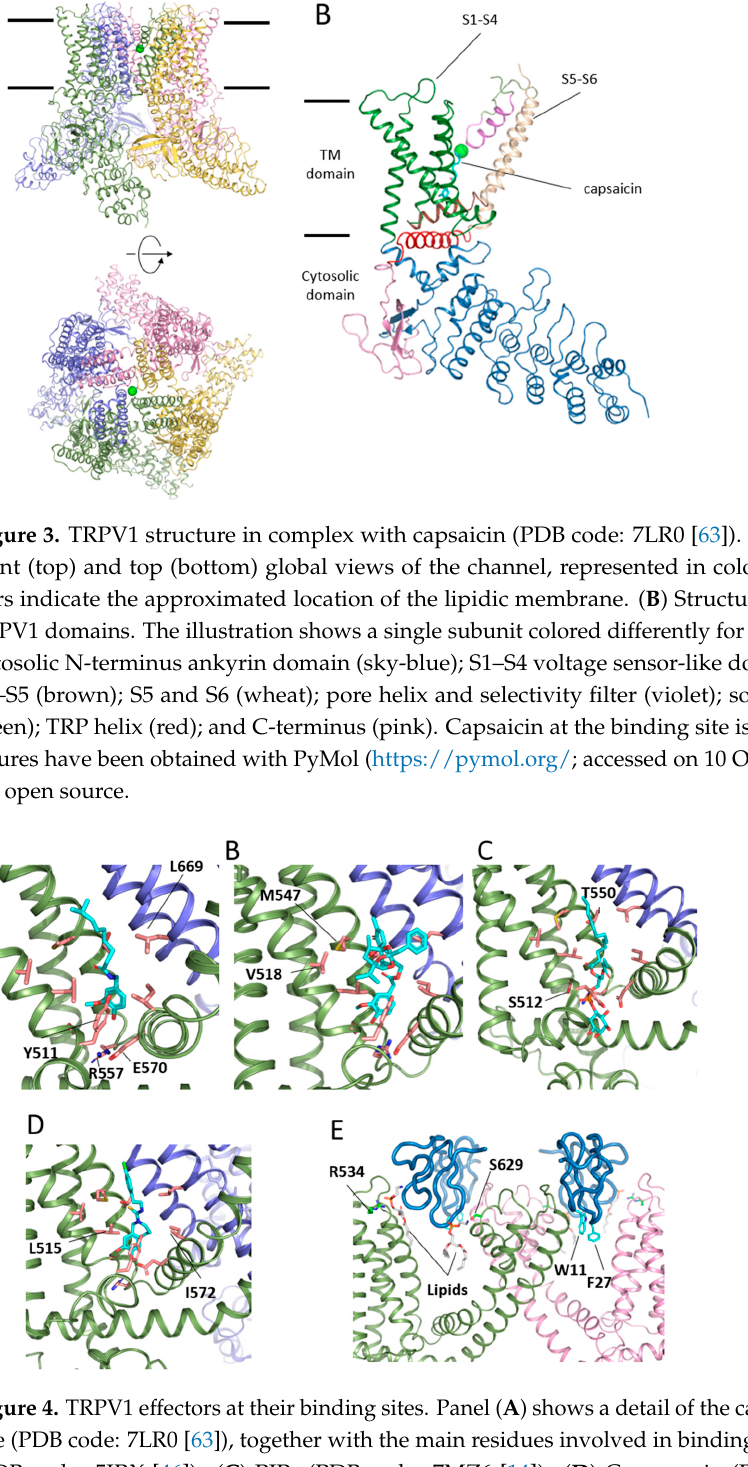
Figure 3. TRPV1 structure in complex with capsaicin (PDB code: 7LR0 [63]). Panel ( A ) shows the front (top) and top (bottom) global views of the channel, represented in colored cartoons. Black bars indicate the approximated location of the lipidic membrane. ( B ) Structural representation of TRPV1 domains. The illustration shows a single subunit colored differently for the distinct domains: cyto ‐ solic N ‐ terminus ankyrin domain (sky ‐ blue); S1–S4 voltage sensor ‐ like domain (green); linker S4– S5 (brown); S5 and S6 (wheat); pore helix and selectivity filter (violet); sodium ion (sphere in green); TRP helix (red); and C ‐ terminus (pink). Capsaicin at the binding site is colored in cyan. All figures have been obtained with PyMol (https://pymol.org/; accesed on 10 October 2022), version 2.5 open source.